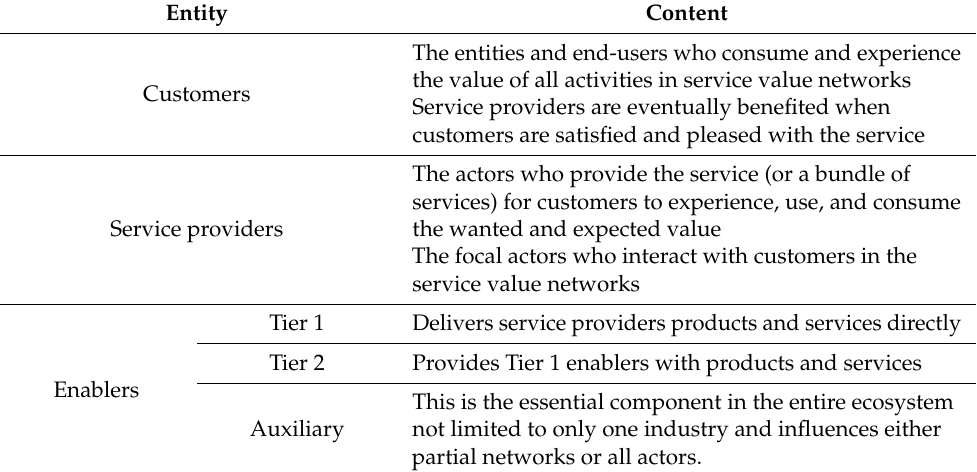
Table 1. SVN entities’ roles and content.